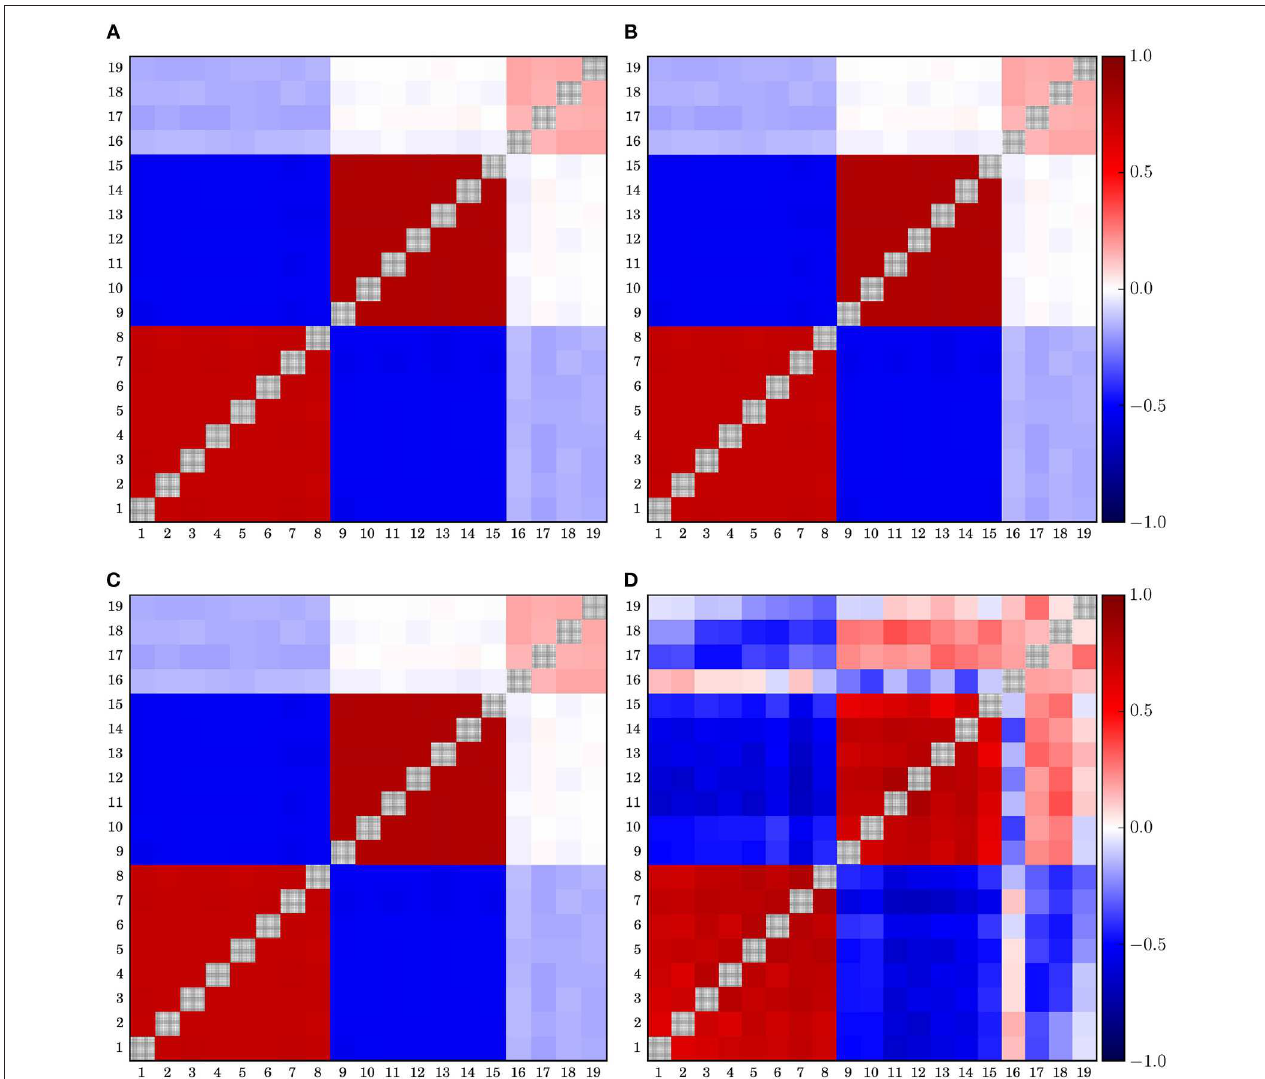
FIGURE 5 | Correlation matrices estimated for median-referenced data previously transformed to different popular EEG-references. (A) A1A2, (B) global average, (C) F3F4, and (D) Hjorth. Data have been derived from Model 7 of Table 1 , like in Figures 1 , 2